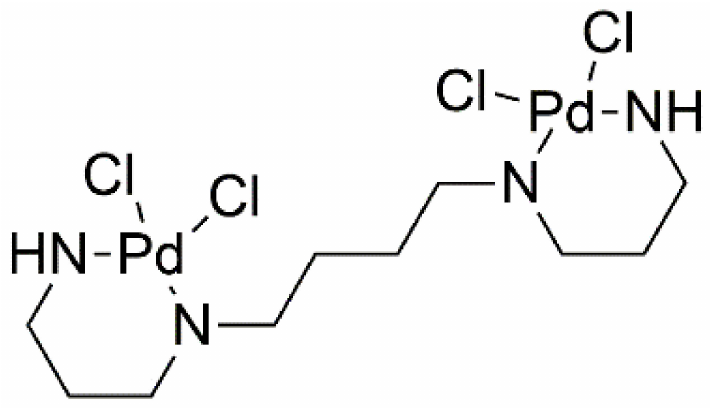
Figure 18. Structure of dinuclear palladium (II)—spermine complex (Pd 2 Spm). A novel dinuclear palladium(II) complex with nitroimidazole as a ligand (Figure 19) incubated with MDA-MB-231 human breast cancer cells induces a three-fold increase in caspase 8, 9, and 10 activities in tumor cells compared to cisplatin. The presented results indicate that the novel palladium(II) complex with nitroimidazole has high proapoptotic activity because caspases 8, 9, and 10 belong to the initiators of apoptosis. The increase in the amounts of their active forms indicate that, in MDA-MB-231 breast cancer cells, the process of physiological cell death has been launched. It is supposed that the active form of this complex is formed by the cleavage of the triazine bond in the berenil molecule that leads to the release of the transition metal (Pd) [48]. Whereas in the next stage, the released Pd is likely transported into the cell, the same as the two basic transporters as cisplatin—human copper transporter protein 1 (Ctr1) and organic cation transporter 2 (OCT2) [49,50]. The investigated compound is a promising alternative to currently used cytostatic drugs, due to almost three-fold stronger stimulation of the apoptosis process and bypassing the resistance of tumor cells